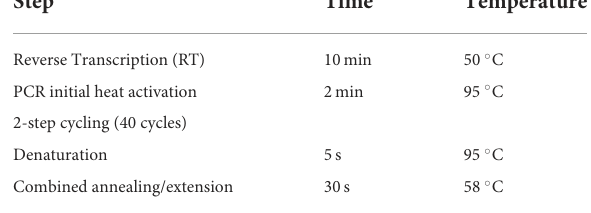
TABLE 2 Cycling